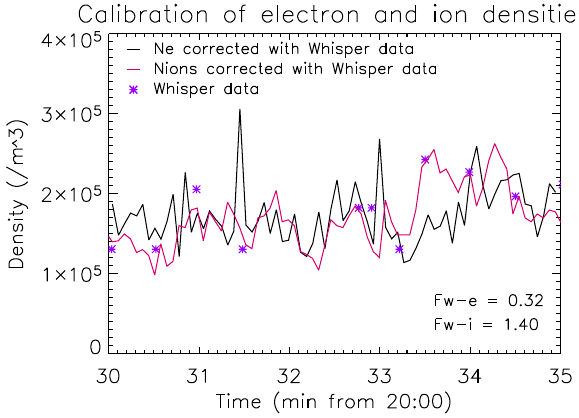
Fig. 11. Electron density from PEACE (black curve) and ion density from CIS (red curve) corrected with WHISPER data